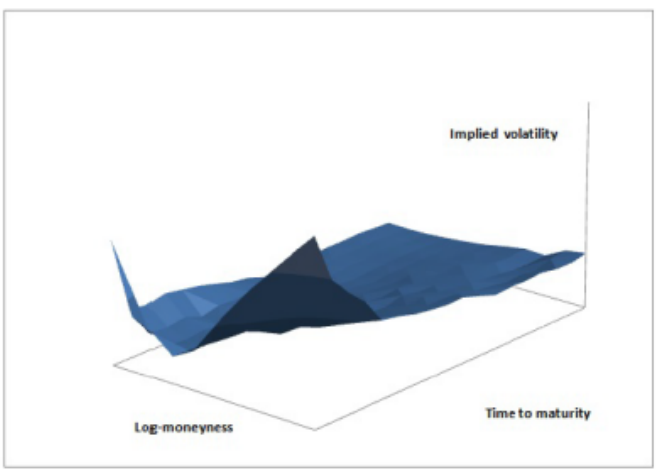
Figure 4. Stock: Apple; expiration: 16 April 2010; data courtesy of Rafael De Santiago (IESE,